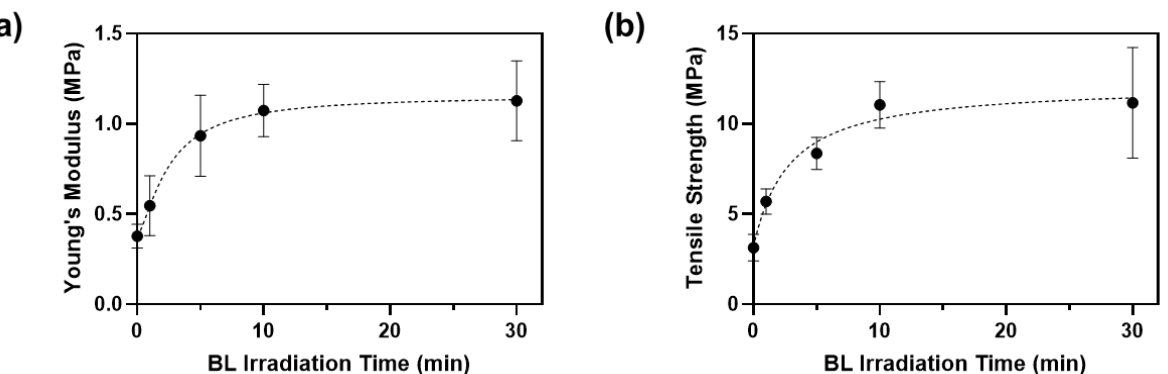
Figure 6. ( a ) Young’s moduli and ( b ) tensile strengths of porcine skins after BL irradiation with 0.05% RFP. The Young’s modulus and tensile strength of porcine skin incubated in PBS without RFP were 0.38 ± 0.05 MPa and 3.14 ± 0.61 MPa, respectively (Table 3). After incubating in the RFP solution and irradiating with BL for 1 min, Young’s modulus and tensile strength